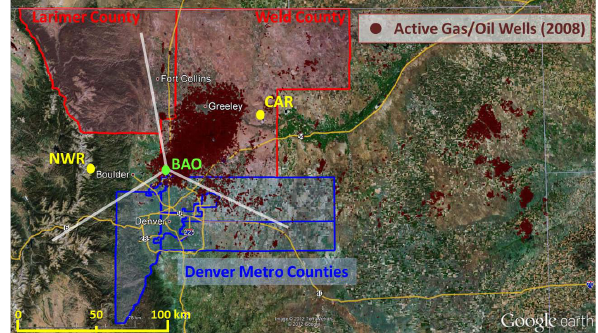
Fig. 1. Map of northeast Colorado showing the BAO tower and the distribution of active oil and gas wells as of 2008 (updated well locations available at: http://cogcc.state.co.us/Home/gismain. cfm). Two background sites are also shown: Niwot Ridge (NWR; 3523m a.s.l.) and the Briggsdale aircraft site (CAR). Also shown are the three wind sectors used to filter the dataset for emission esti- mates in Weld/Larimer counties (North and East) and in the Denver metro counties (South). The Denver metro counties include Denver, Broomfield, Adams, Arapahoe, and Jefferson. Top left corner of this map is: 41.064 ◦ N, 106.248 ◦